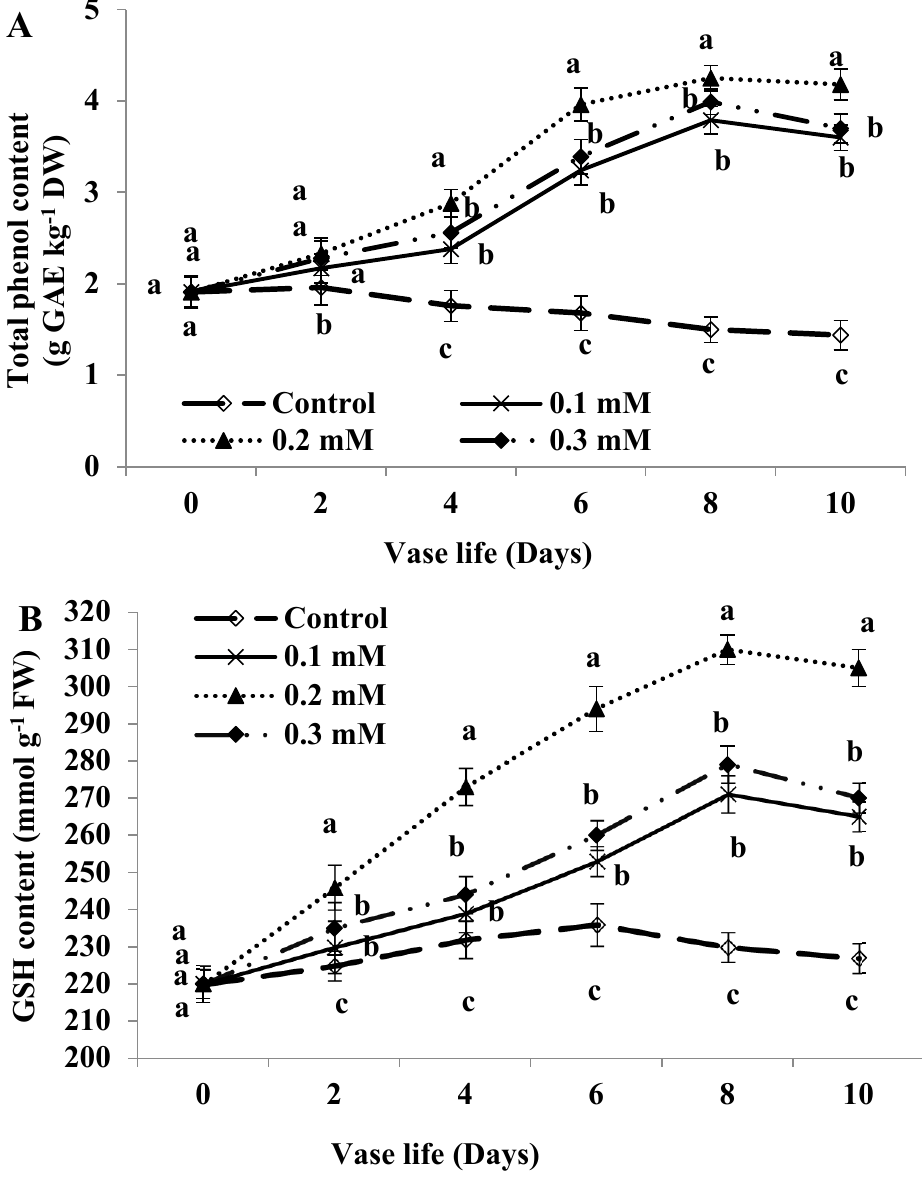
Figure 3. Total phenol content ( A ) and glutathione (GSH) content ( B ) of cut roses treated with melatonin at 0.1, 0.2 and 0.3 mM. Each value is the mean ± SE of two experiments. Values that have different letters are significantly different based on Tukey-Kramer’s multiple range test at p ≤ 0.05.